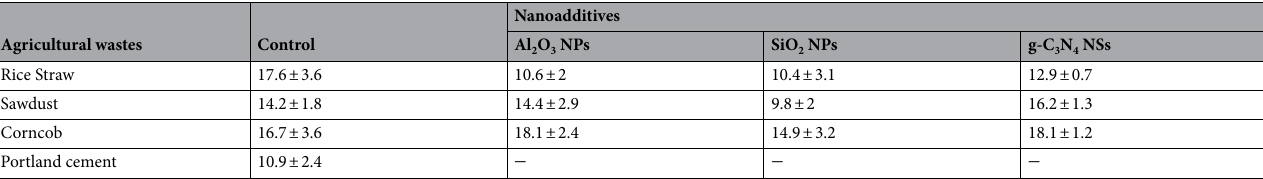
Table 3. Compressive strength test (MPa) results of different nano additives to agricultural waste’ bio-cement.